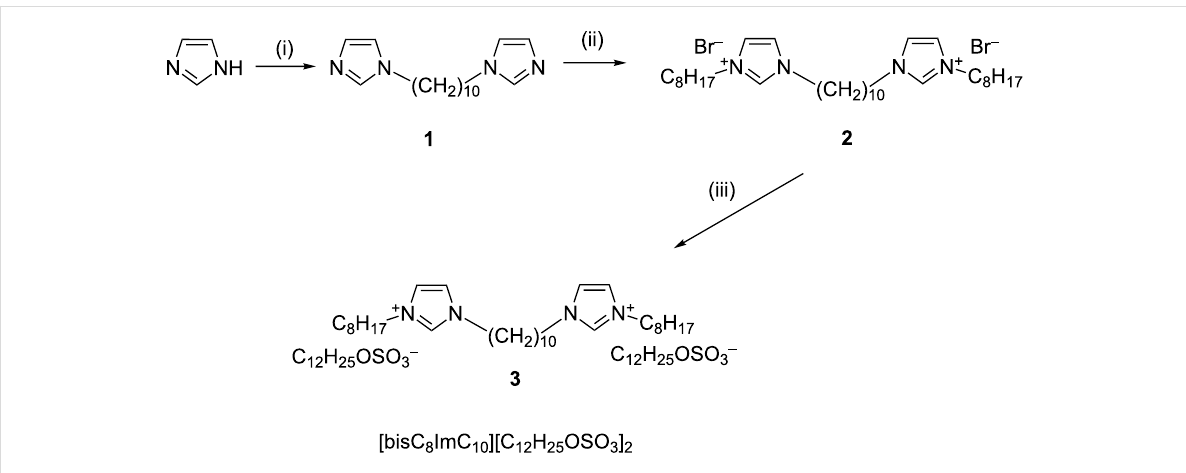
Carbon nanotubes (CNTs) and nanoparticles were also dis- persed in LCs [33-36]. It is well-known that the order of the LCs can be imposed on the CNTs in such a way that the align- ment axis of the CNTs is driven by the LC reorientation con- trolled by an electric field [37]. The concentration and the spatial distribution of charges in the LC matrix will be affected by the presence of CNTs and, hence, the conductivity will be changed